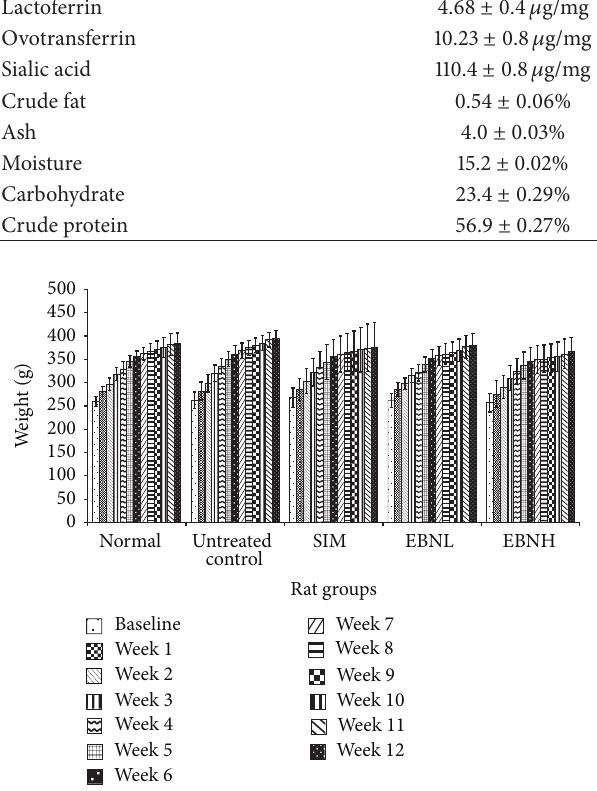
Figure 2: Effects of edible bird’s nest (EBN) on body weight changes in high fat diet- (HFD-) fed rats over 12 weeks. The normal group received standard rat chow, while the other groups received HFD containing 4.5% cholesterol and 0.5% cholic acid (untreated control group), HFD containing 4.5% cholesterol and 0.5% cholic acid + 10mg/kg/day simvastatin (SIM), HFD containing 4.5% cholesterol and 0.5% cholic acid + 2.5% EBN (EBNL, EBN low), or HFD con- taining 4.5% cholesterol and 0.5% cholic acid + 20% EBN (EBNH, EBN high).